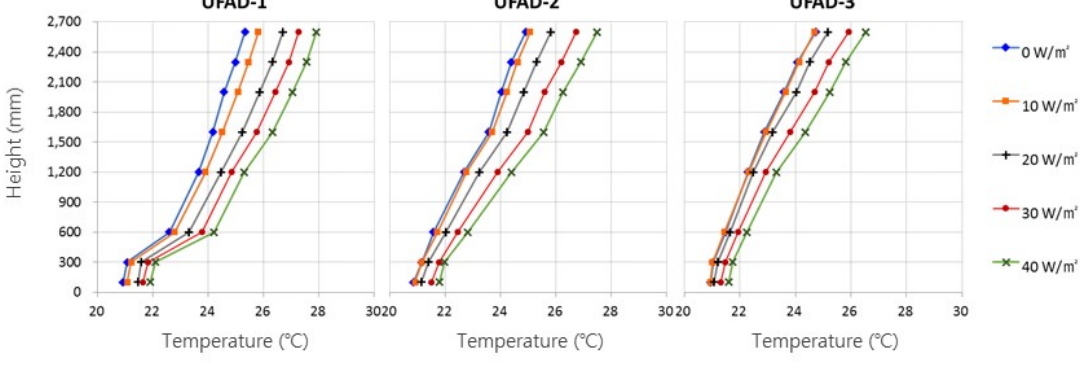
Figure 16. Vertical temperature distribution at (X1, Y1), UFAD.